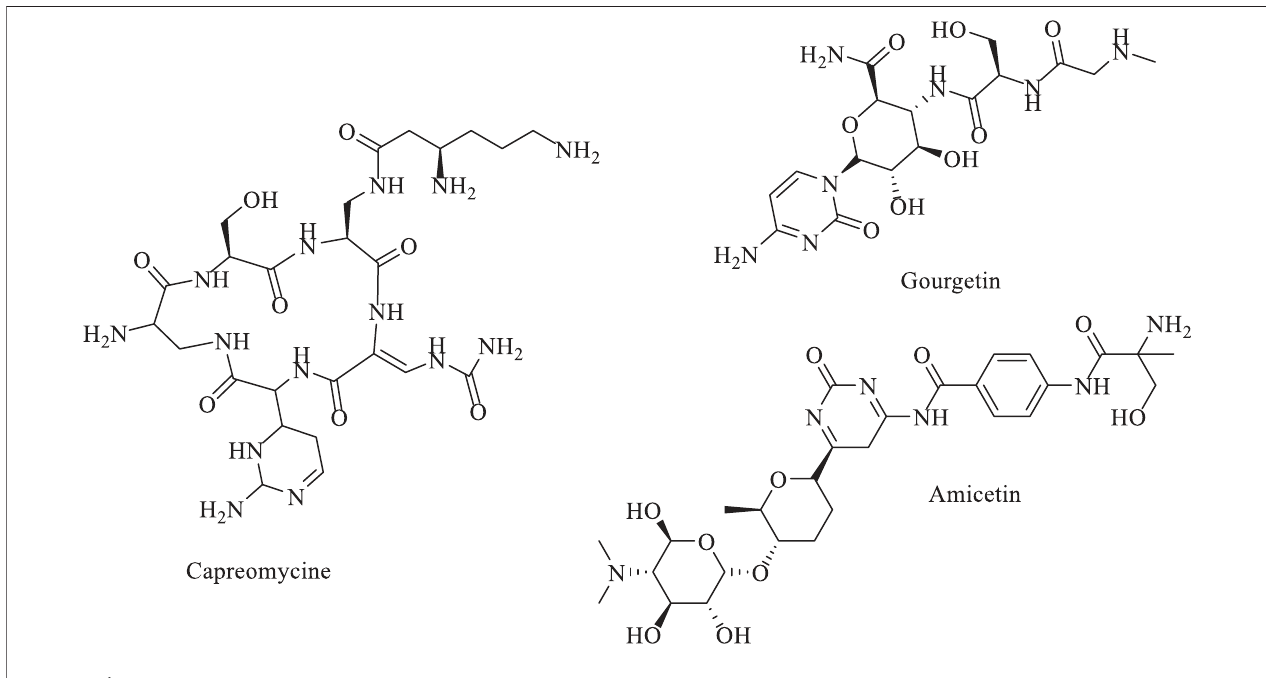
FIGURE 1 | Some commercial drugs containing pyrimidine